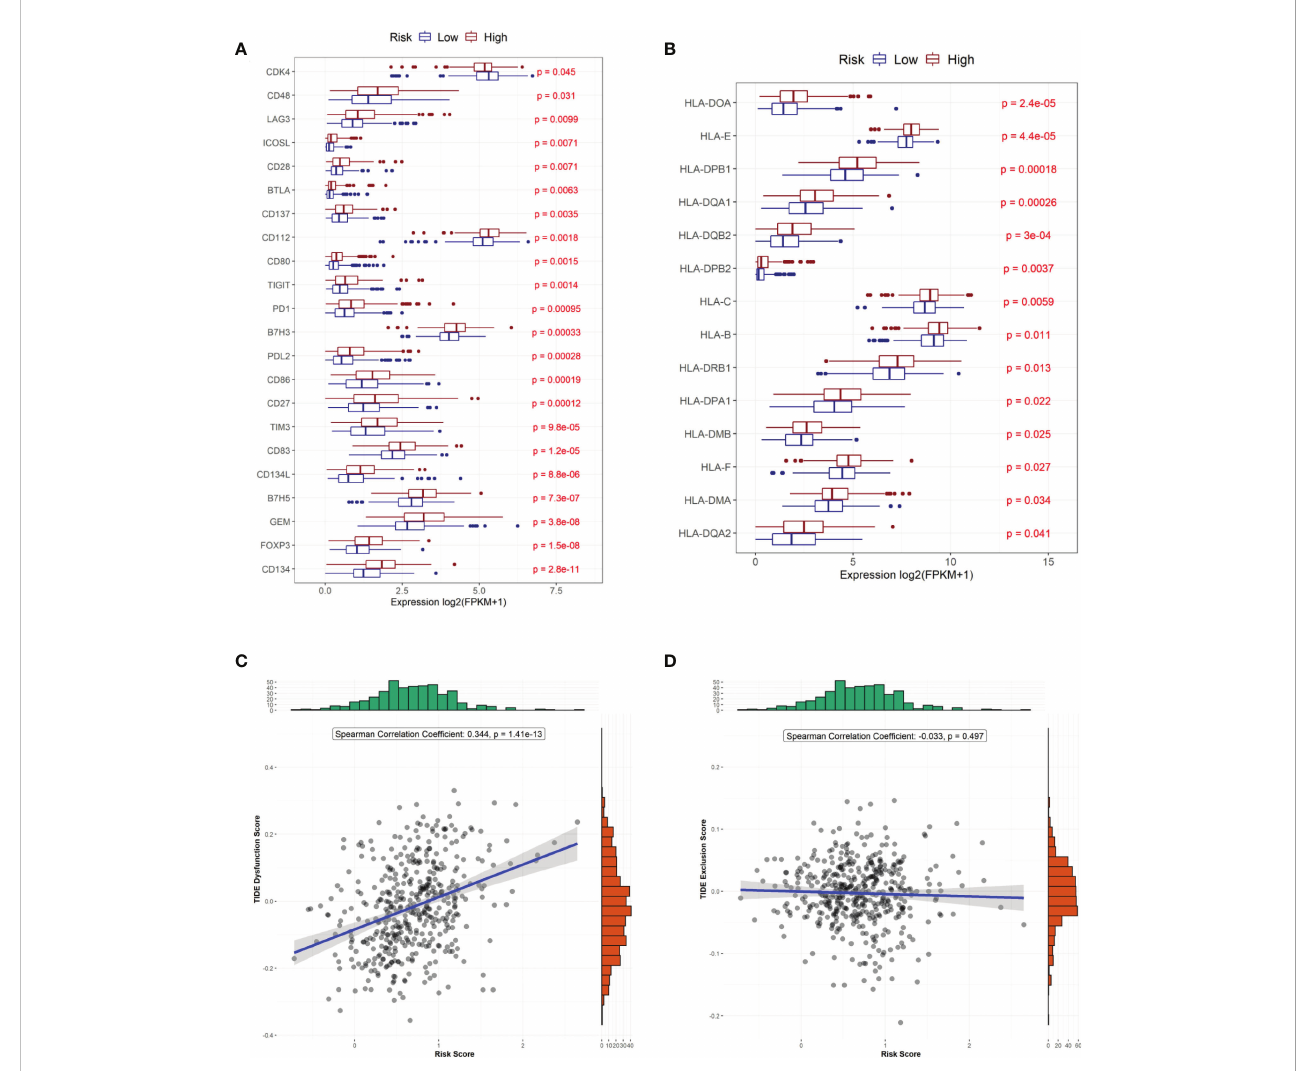
FIGURE 6 Predicted treatment sensitivity in patients with different risk scores. (A) Differential expression of immune checkpoint molecules. (B) Differential expression of HLA molecules. (C) Risk score versus immune disorder score. (D) Correlation between risk and immune rejection